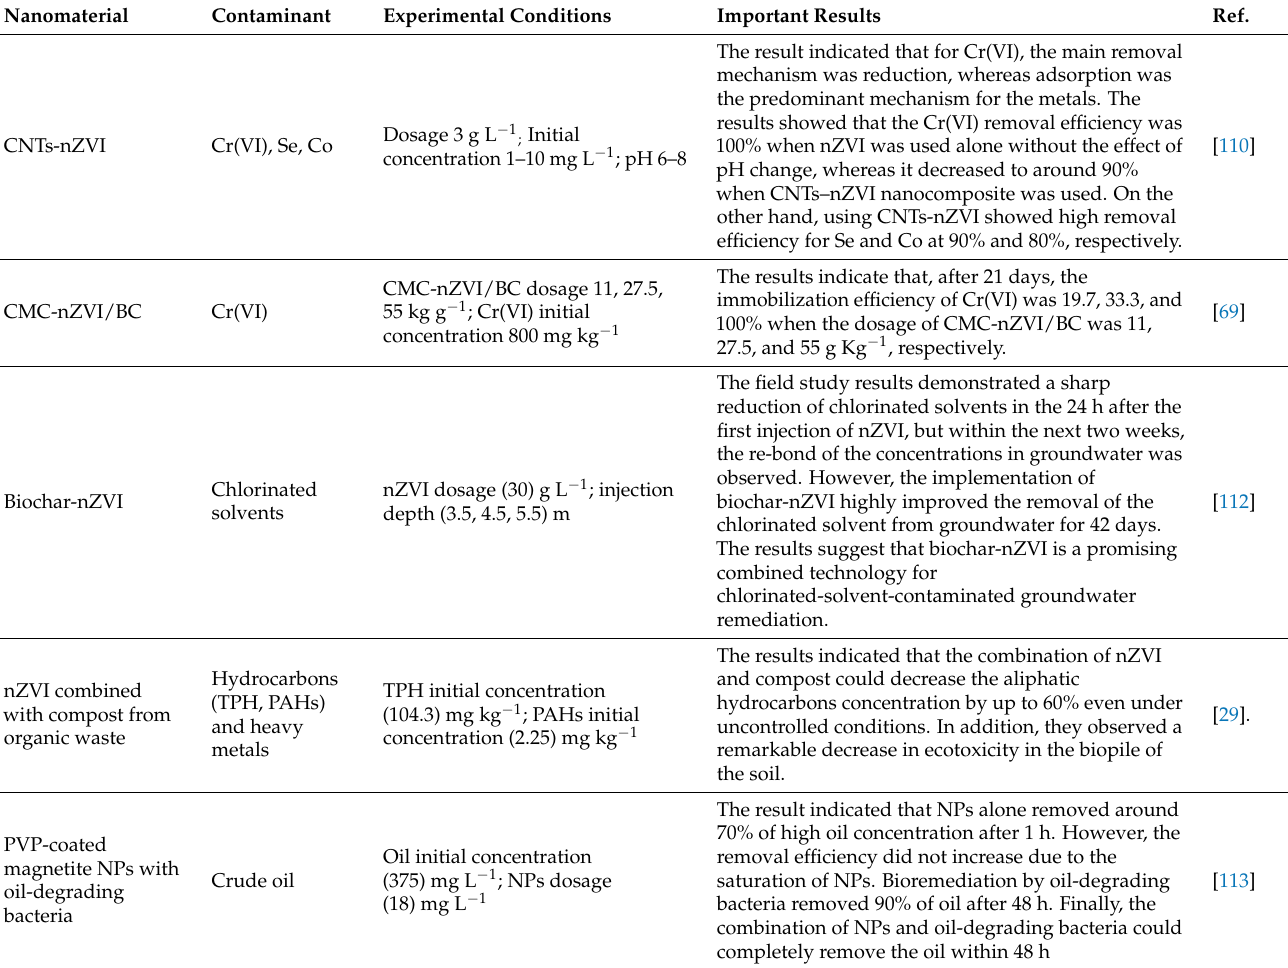
Table 3. Recent studies employed the combination of nanoremediation technologies with other remediation methods. Nanomaterial Contaminant Experimental Conditions Important Results